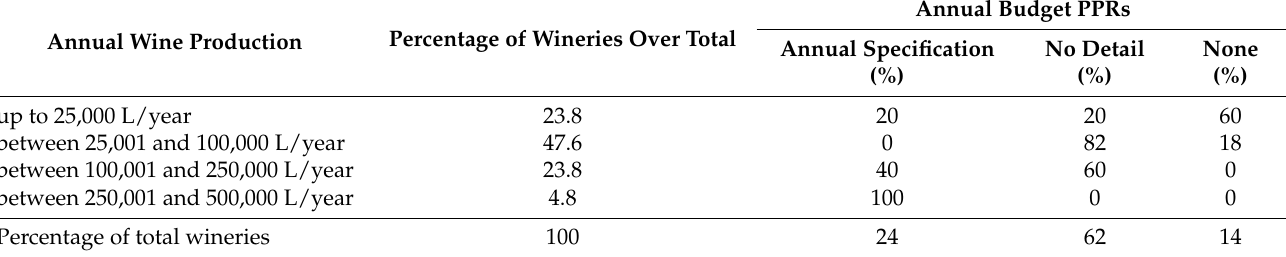
Table 3. Annual budget of existing PPRs by type of winery, according to their annual wine production and by the total of the